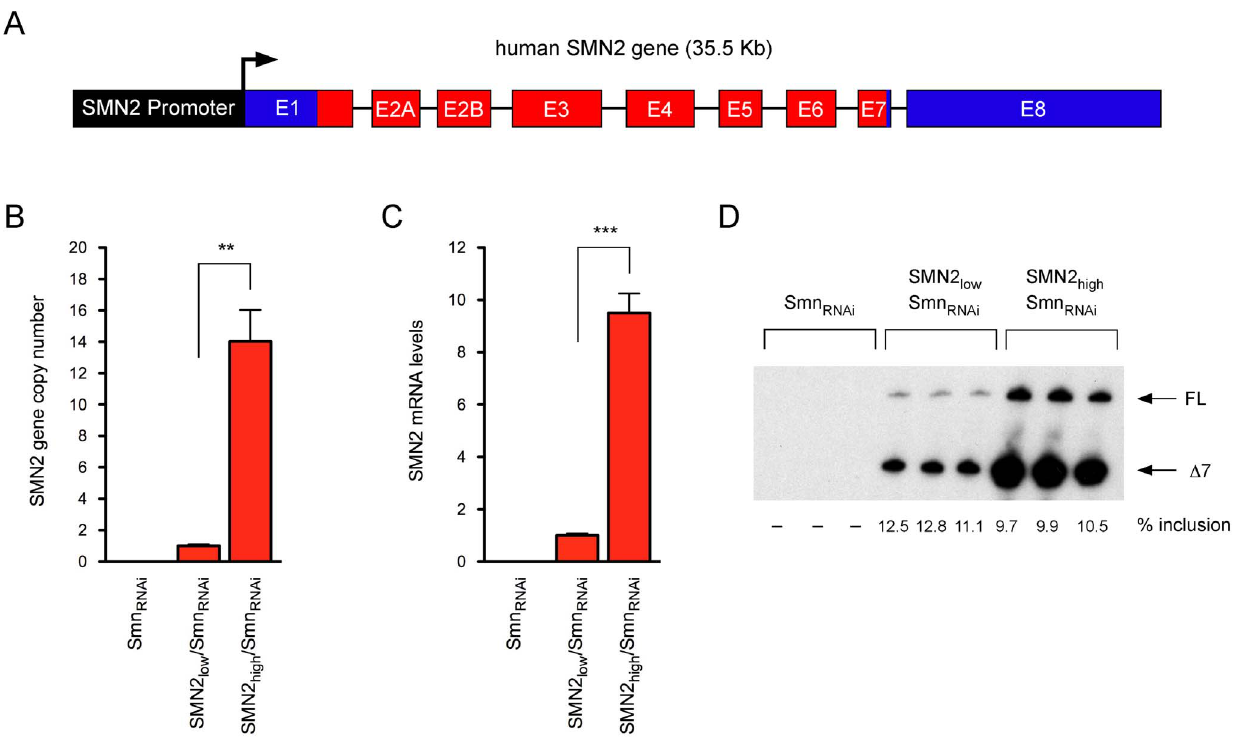
Figure 1. Development of SMN2 -containing NIH3T3 cell lines with inducible knockdown of endogenous Smn. (A) Schematic representation of the exon-intron structure of the human SMN2 gene used to establish NIH3T3-SMN2/Smn RNAi cell lines (introns not drawn to scale). (B) Analysis of SMN2 gene copy number in the indicated NIH3T3 cell lines by qPCR. Data were normalized to the Gapdh gene and expressed relative to the NIH3T3-SMN2 low /Smn RNAi cell line. Data are represented as mean and SEM (n=3; **=p , 0.01; t-test). (C) Analysis of total SMN2 mRNA levels in the indicated NIH3T3 cell lines by RT-qPCR. Data were normalized to Gapdh mRNA and expressed relative to the NIH3T3-SMN2 low /Smn RNAi cell line. Data are represented as mean and SEM (n=3; ***=p , 0.001, t-test). (D) Analysis of SMN2 exon 7 splicing in the indicated NIH3T3 cell lines by radioactive RT-PCR. The levels of exon 7 inclusion are shown at the bottom.